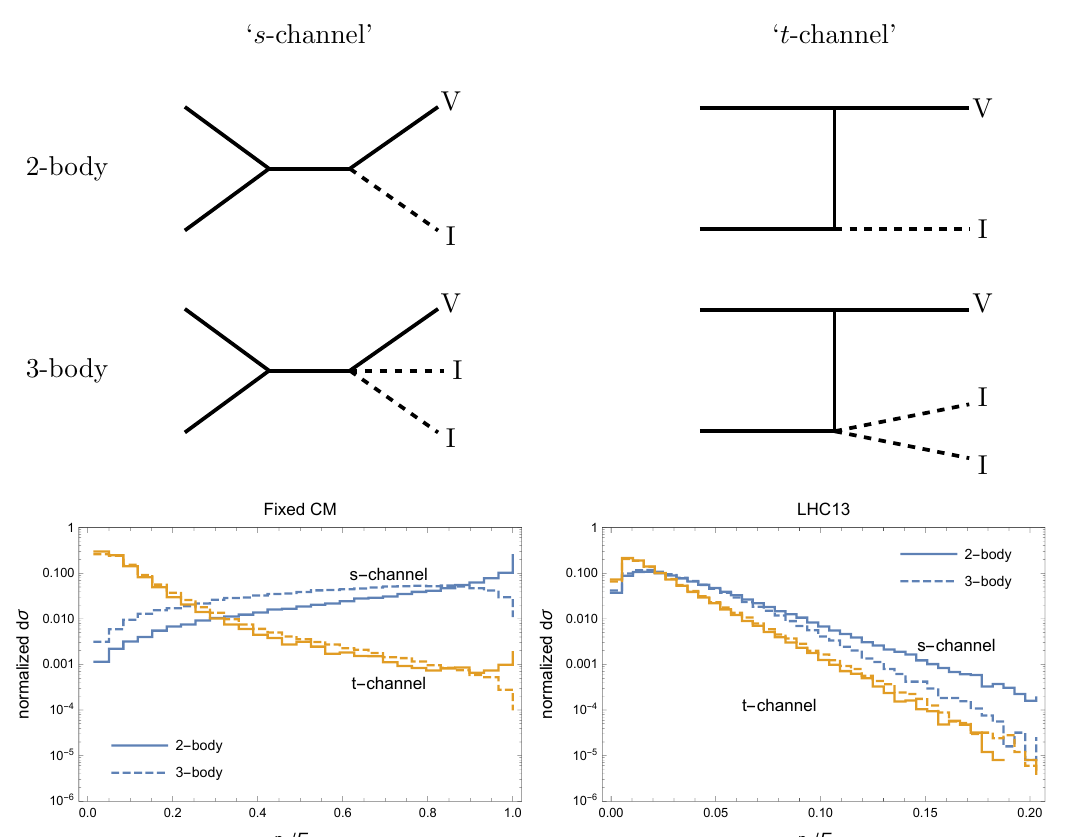
Figure 5 . Normalized MET distributions for ‘ s -channel’ and ‘ t -channel’, 2- and 3-body topologies, with visible (cid:12)nal state V and invisible states I . The 2-body t -channel topology corresponds to the irreducible SM di- Z background, as well as (cid:31) (cid:22) (cid:31)Z production via an on-shell mediator. A compressed dark state produced instead via an o(cid:11)-shell gauge boson mediator, as it is here, is a 3-body, t -channel